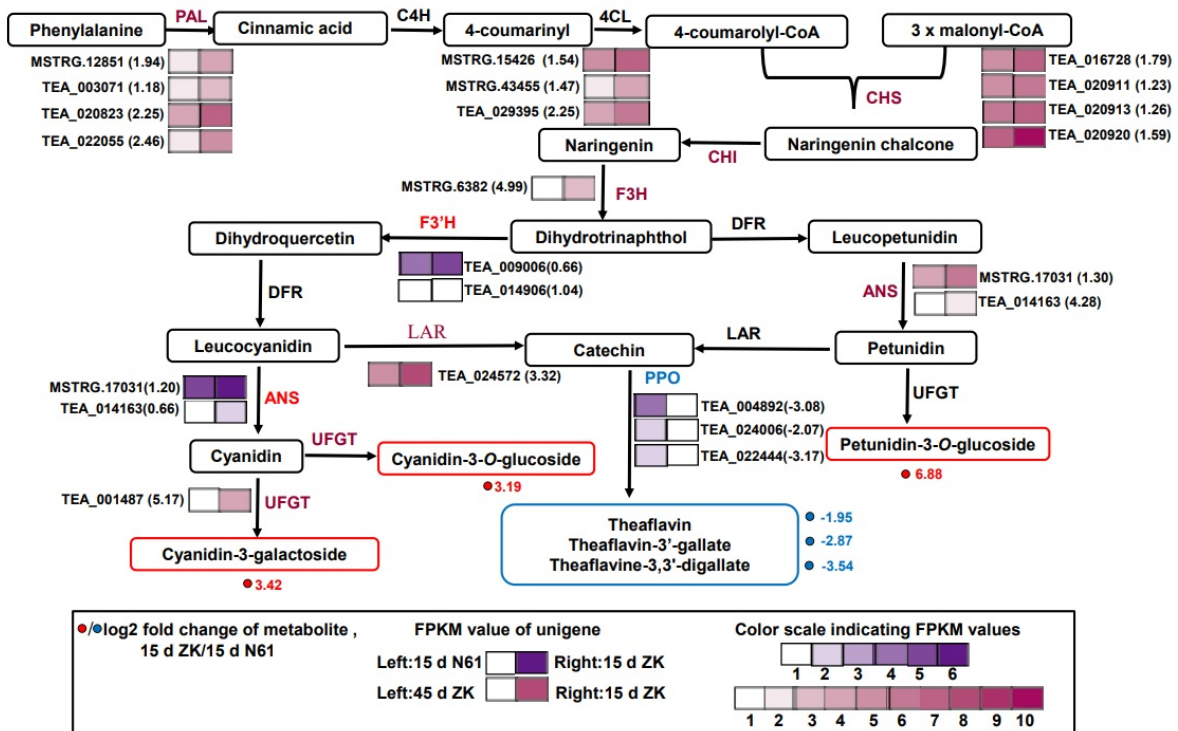
Figure 5. Transcriptional profiling of genes involved in the phenylpropane and flavonoid biosynthesis pathways in Zikui (ZK) and N61 tea cultivars. Grids with a purple color scale from light to dark represent fragments per kilobase of exon per million fragments mapped (FPKM) values of 0–10, 10–20, 20–40, 40–80, 80–160, and 160–320. Grids with a red color scale from light to dark represent FPKM values of 0–10, 10–20, 20–40, 40–80, 80–160, 160–320, 320–640, 640–1280, 1280–2560, and